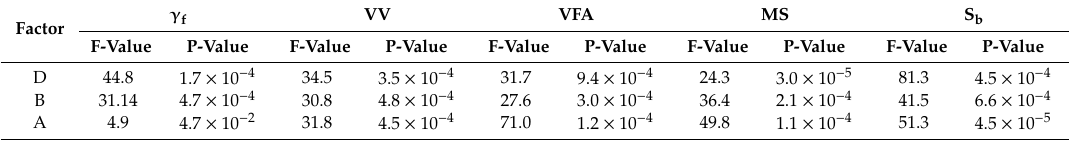
Table 8. Variance analysis of the e ff ect of test factors on the test